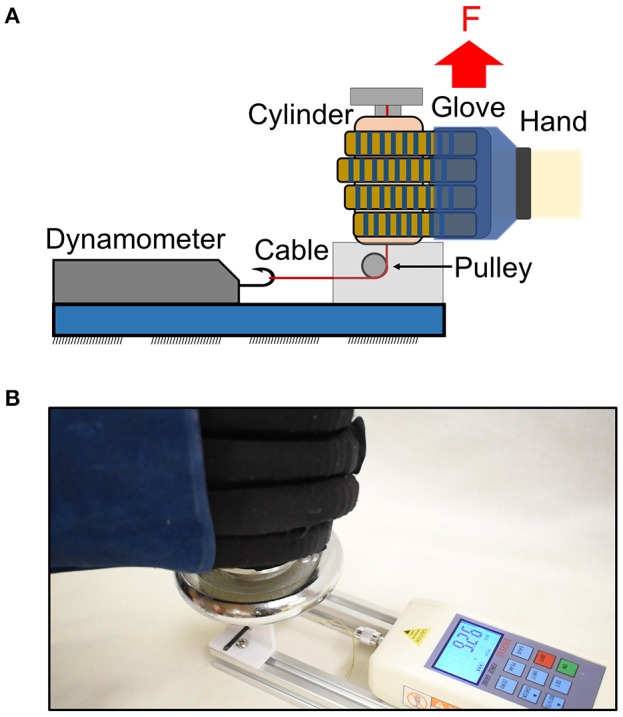
(A) Schematic and (B) the real setup of a portable setup with dynamometer to measure the glove-assisted grip strength. Maximum frictional grip force was recorded before the cylinder released from the actuators' grip.